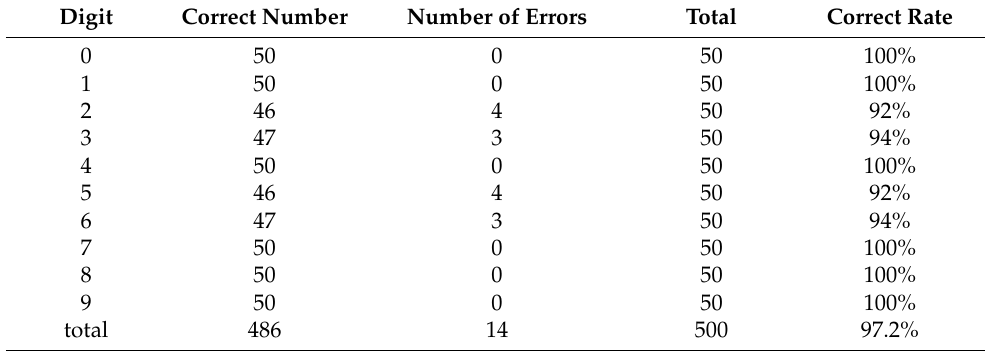
Table 4. Recognition results of digital input.